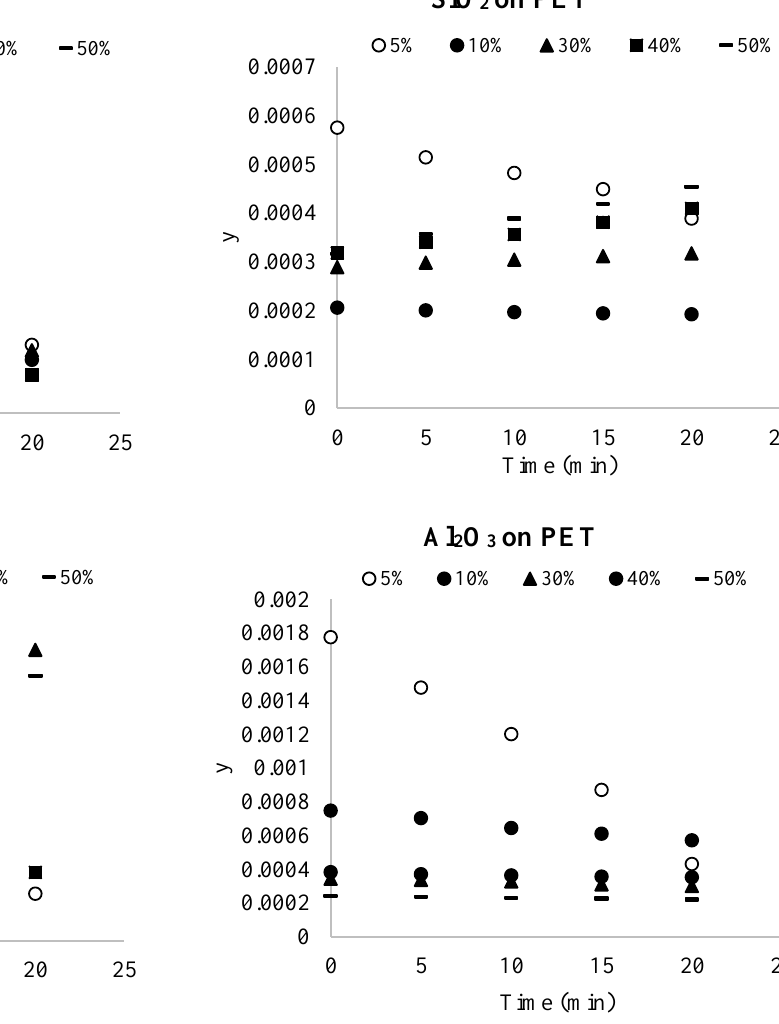
and Al O on glass and 2 2 3